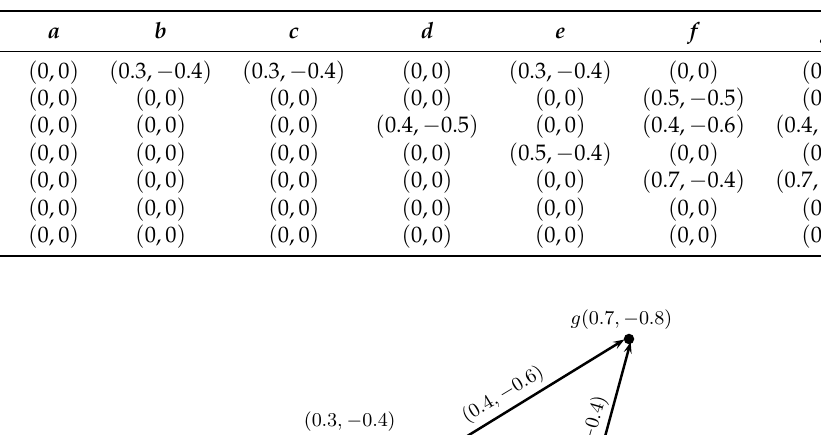
Table 1. Adjacency matrix.